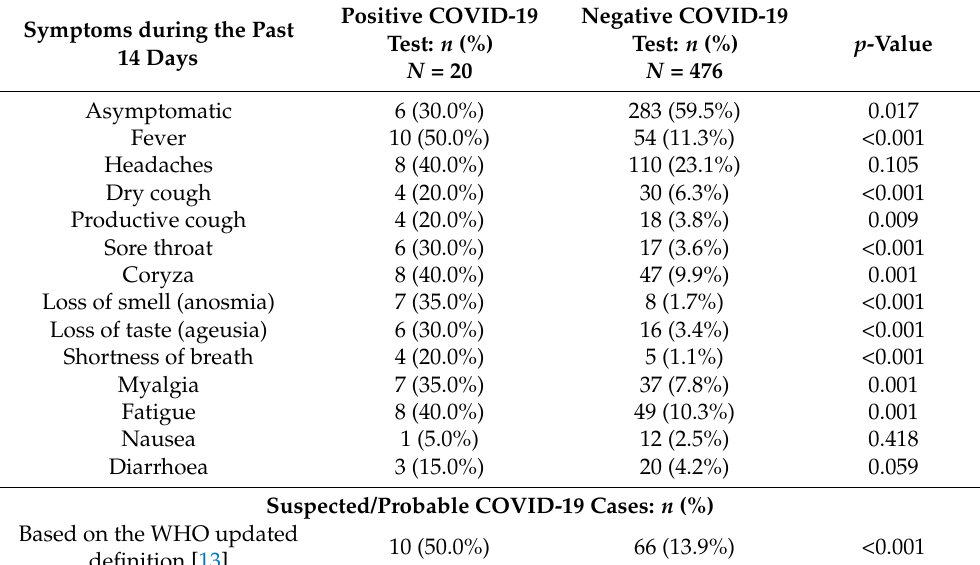
Table 4. Flu-like symptoms and COVID-19 test results within the two weeks preceding participation in the survey.